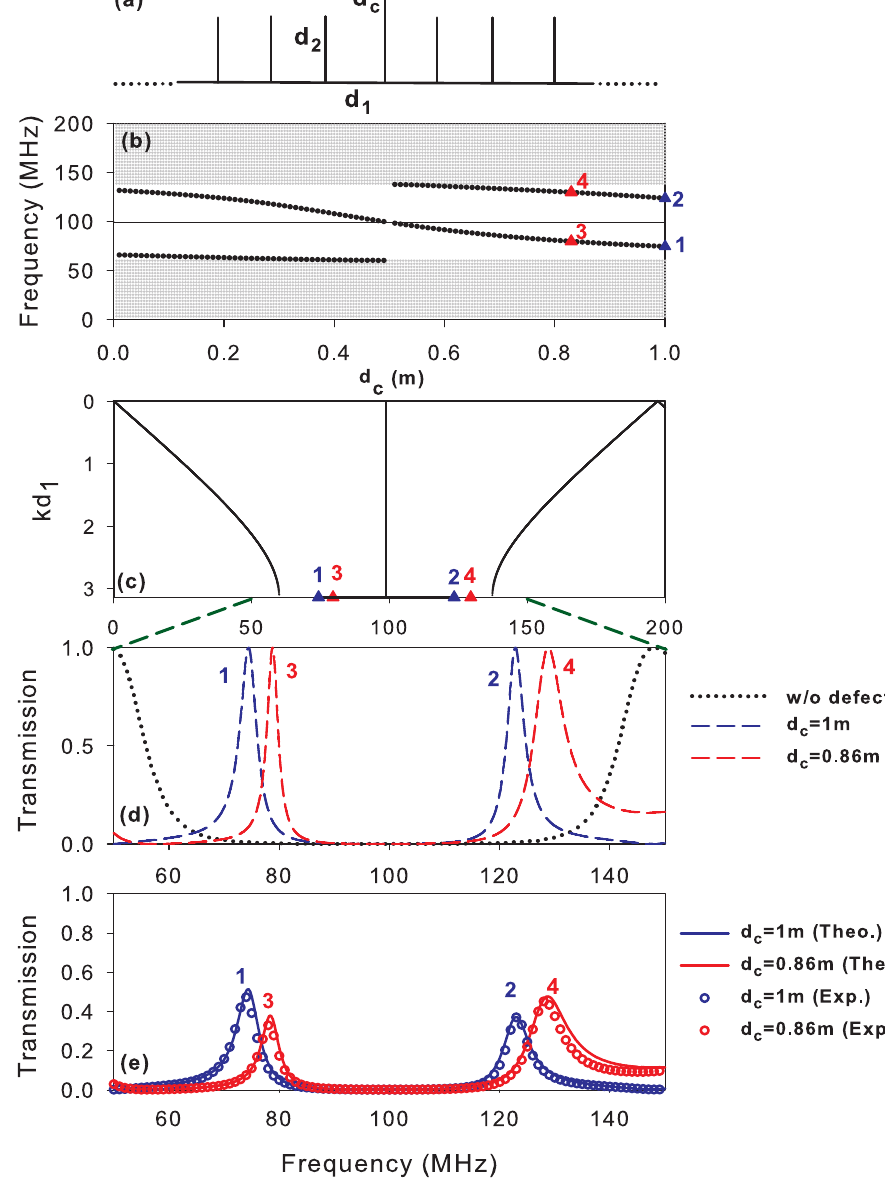
Figure 8. ( a ) Schematic illustration of an infinite comb structure with a cavity of length d c . ( b ) Projected band structure of an infinite comb structure (shaded areas) and cavity modes (dots) versus the length d c of the stub’s defect. Red and blue triangles give the positions of the cavity modes for d c = 0.86 m and d c = 1 m respectively. ( c ) Dispersion curves of an infinite comb structure in the reduced Brillouin zone. ( d ) Transmission through a finite lossless comb structure formed by three identical stubs (black dotted curve), with cavity defects d c = 1 m (blue curve) and d c = 0.86 m (red curve). ( e ) Experimental (open circles) and theoretical (solid lines) results for a lossy